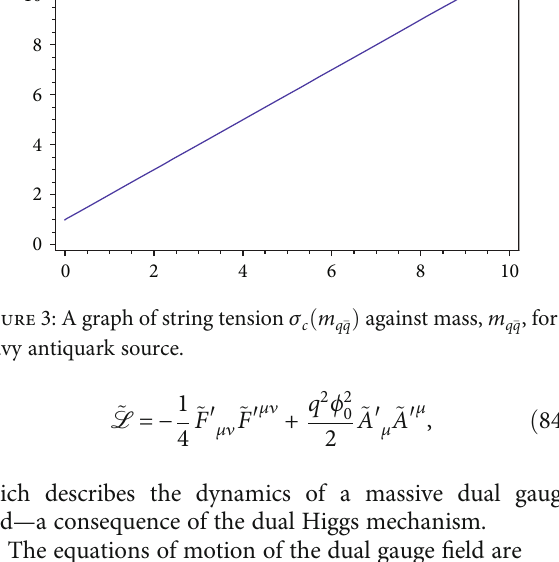
, for a q (cid:1) q